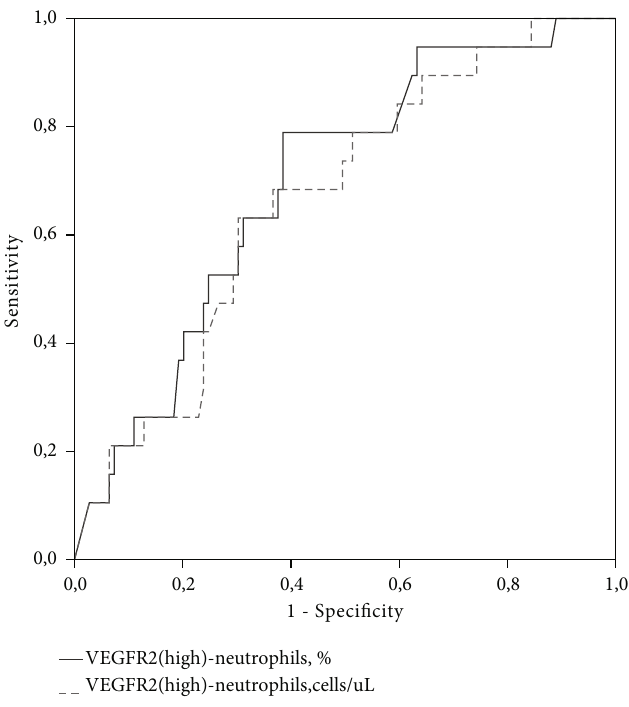
Figure 3: ROC curve demonstrating the diagnostic signi fi cance of VEGFR2 hi -neutrophils in relation to the high carotid plaque burden ( cPTm > 2 : 1 mm